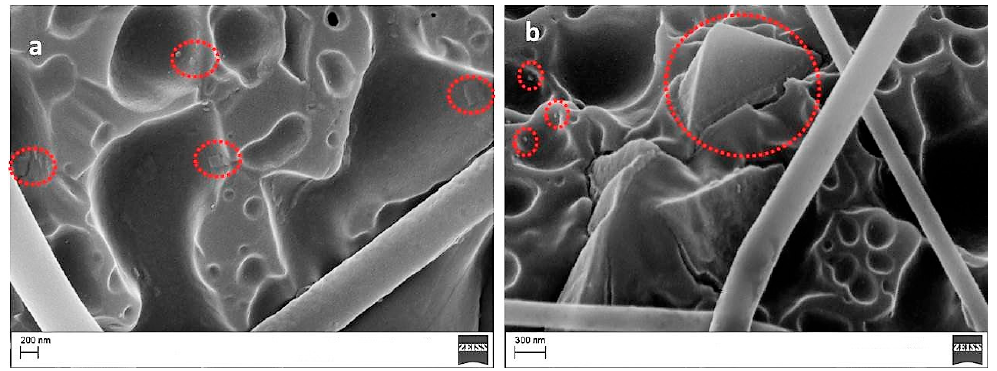
Figure 3. SEM images of electrospun PES containing 5% ( a ) and 10% POSS ( b ) (POSS micro and nanocrystallites are indicated by red dotted circles).